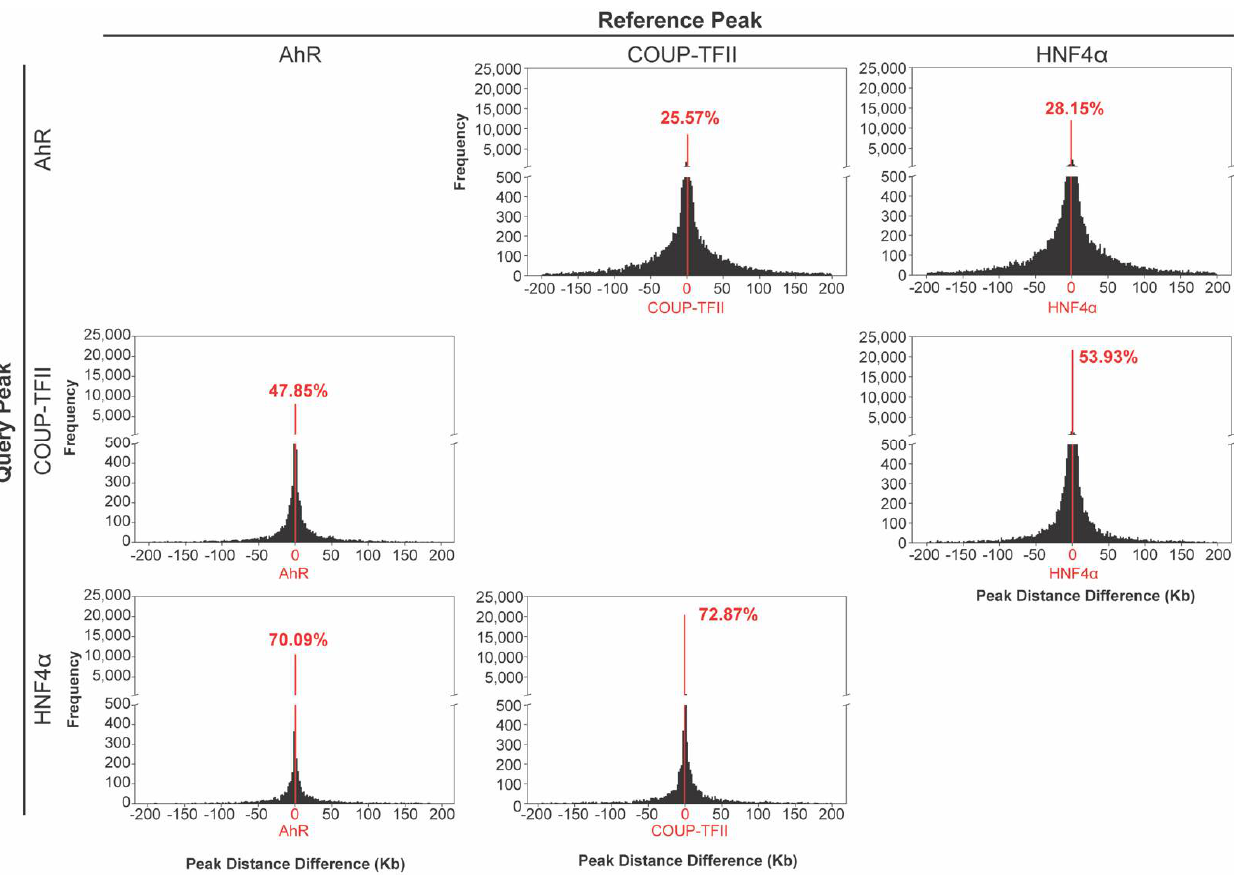
Figure 3. Evaluating overlap of intragenic peaks. Intragenic peaks for AhR, COUP-TFII and HNF4α were assessed for proximity of chromatin binding location following a 2 h single oral gavage of 30 µg/kg TCDD. The distance (Kb) prevalence between transcription factor peak centers is denoted in each histogram. The number of overlapping peaks out of the total number of peaks for the reference transcription factor is denoted in red as a percentage.